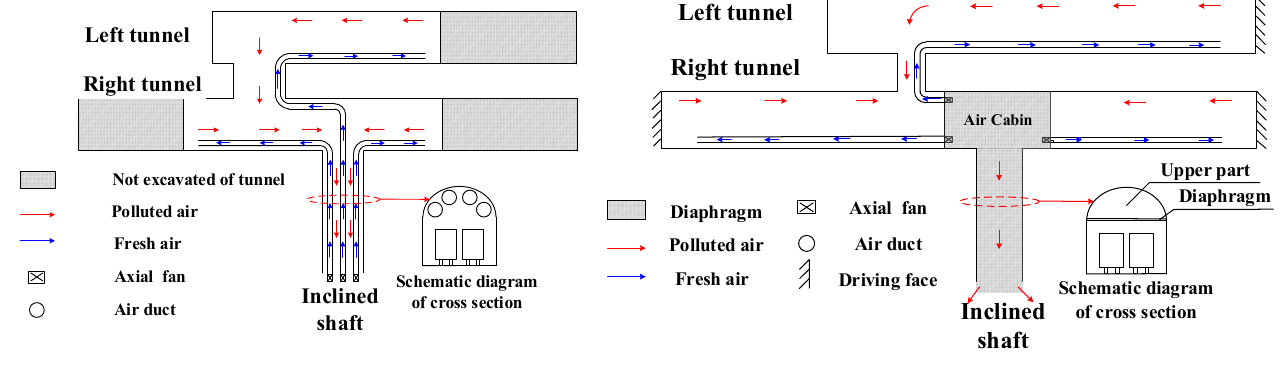
Figure 1. Ventilation system diagram.